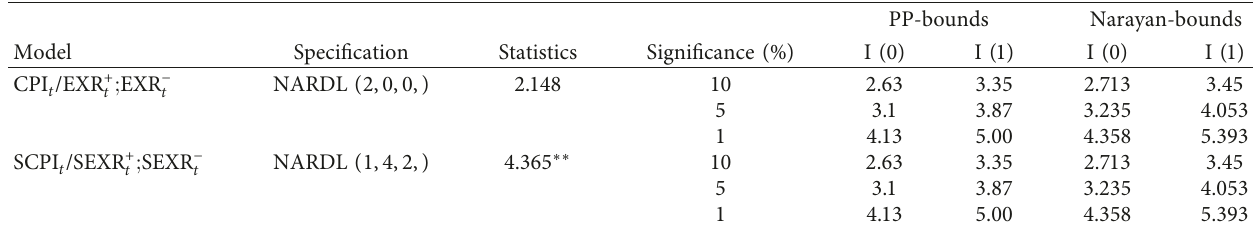
Figure 1: EMD denoised series (red) versus original series (blue). Table 4: Results of NARDL Bound test.